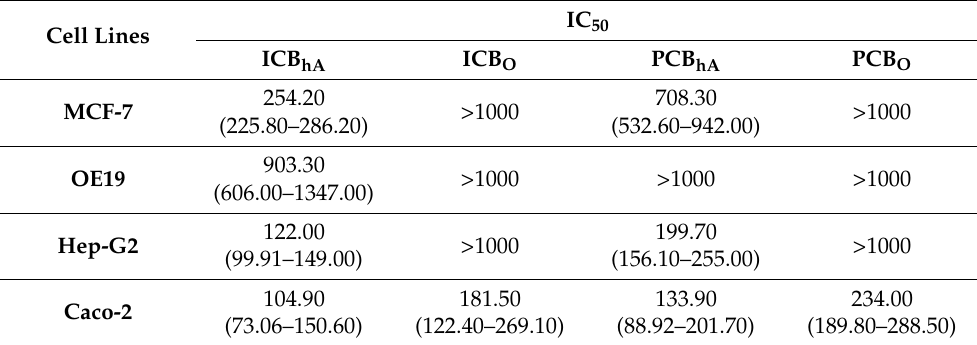
Table 4. 3-(4,5-Dimethylthiazol-2-yl)-2,5diphenyl-tetrazolium bromide (MTT) assay, concentration inhibiting the 50% cell growth rate (IC 50 ) values. IC 50 values ( µ g/mL) with confidence intervals of 95% (in brackets) obtained on MCF-7, OE19, Hep-G2, and Caco-2 human cell lines exposed to hydroalcoholic and chloroform extracts of ICB and PCB samples.